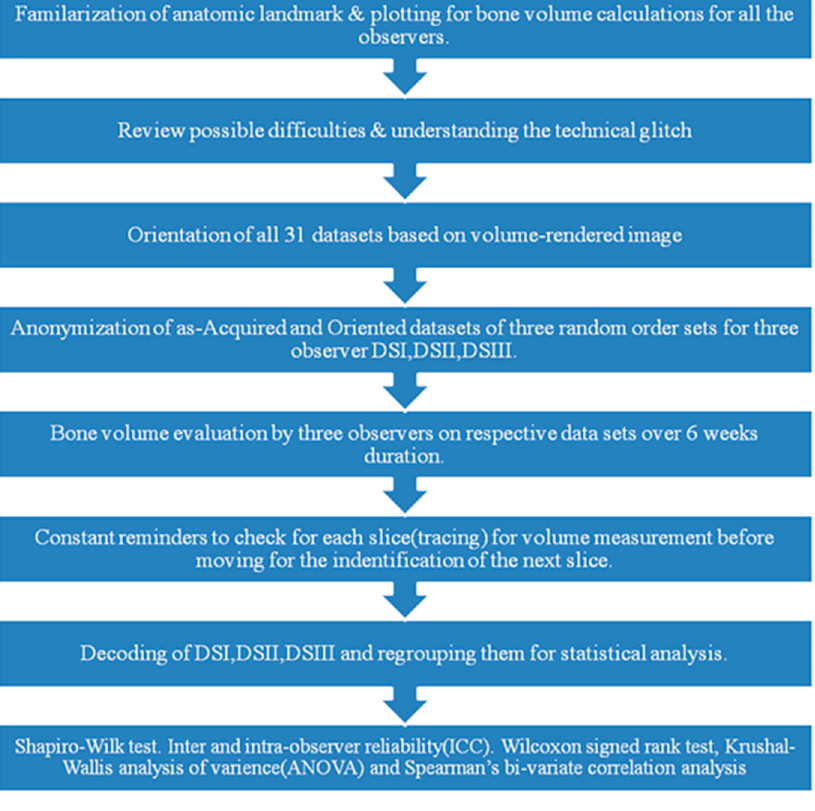
Figure 1. Flowchart representing the methodology.